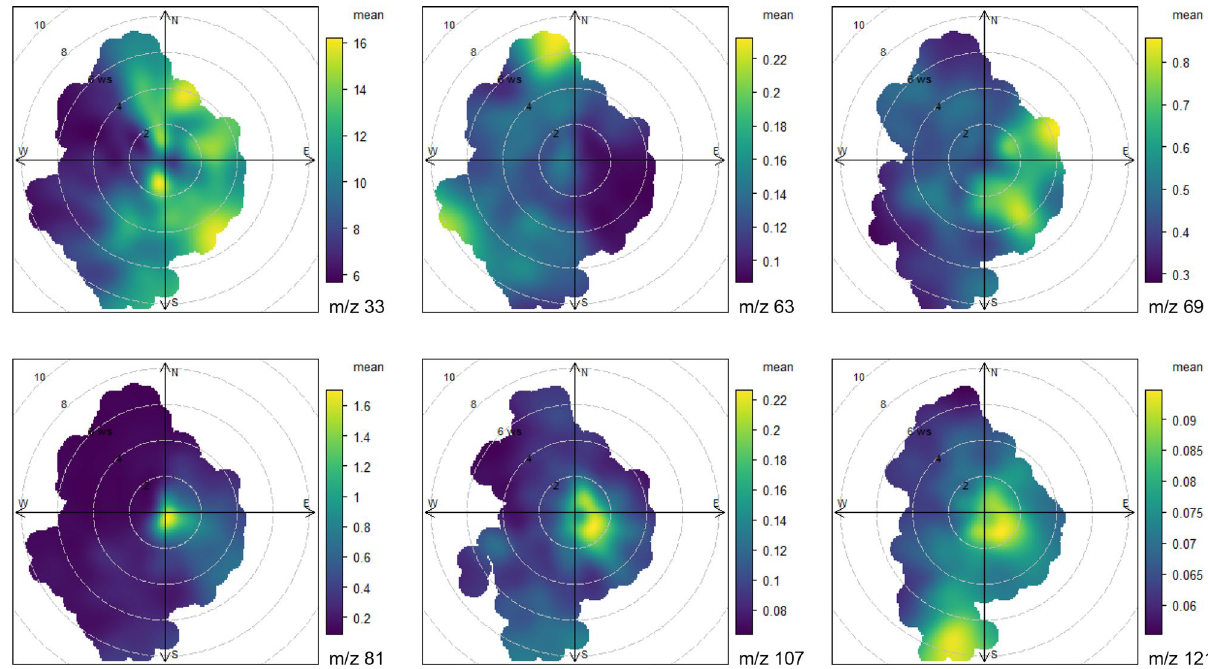
Figure 4. Spatial distributions of measured VOCs reported as protonated masses and identified as: methanol ( m/z 33 ), DMS ( m/z 63 ), isoprene ( m/z 69 ), sum of monoterpenes ( m/z 81 ), sum of xylenes ( m/z 107 ), trimethylbenzene ( m/z 121 ). Mean campaign values of VOCs (colored scale) are showed as a function of wind direction (angle) and wind speed (radius). Figures drawn with